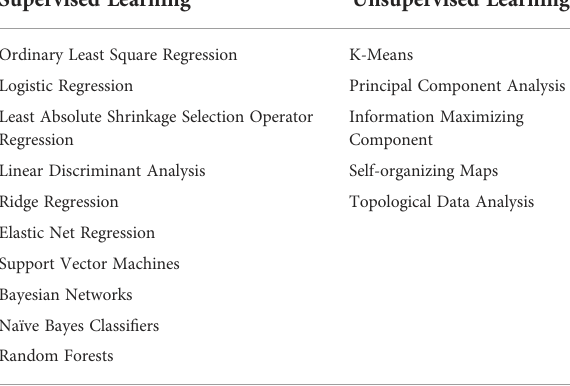
TABLE 3 Categories of supervised learning and unsupervised learning for common algorithms. Supervised